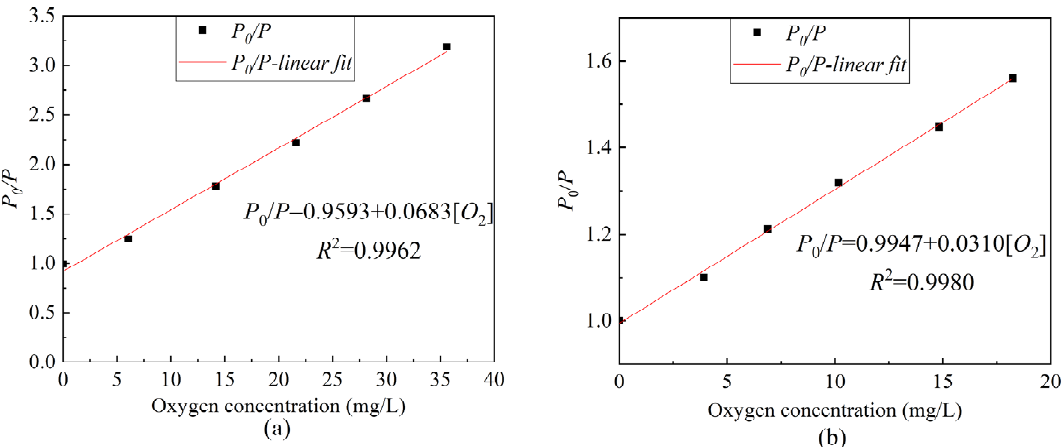
Figure 9. The ratiometric Stern–Volmer equation curve of composite sensitive film under different oxygen concentrations ( a ) gaseous oxygen environment, ( b ) dissolved oxygen environment. Table 1. Comparison of different ratiometric dissolved oxygen sensors. λ exc and λ em are spectral peaks of excitation and emission, respectively; SVP means Stern-Volmer plot; I R = I 0 /I 100 is the ratio of fluorescence intensity at 0% O 2 and 100% O 2 .